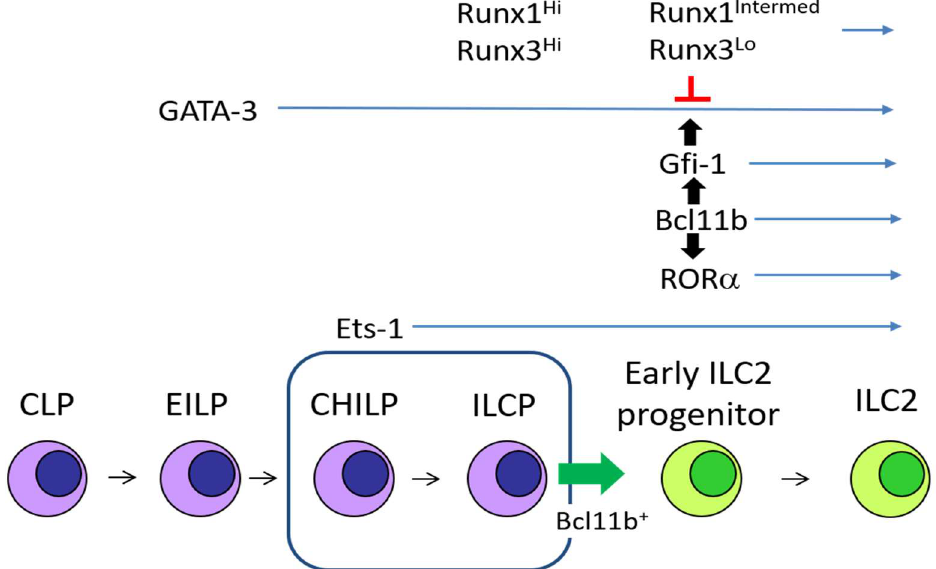
Figure 1. Group 2 innate lymphoid cells (ILC2) differentiation and transcription factors. GATA-3 is expressed in early innate lymphoid progenitor cell (EILP), and its expression is maintained in all ILC subsets. Ets-1 up-regulates Id2 in common helper innate lymphoid progenitors (CHILP). Bcl11b-expressing progenitors in the CHILP population give rise to ILC2 (green blocked arrow). Bcl11b positively regulates RORα and Gfi-1 both of which are indispensable for ILC2 differentiation (black blocked arrow from Bcl11b). Gfi-1 induces GATA-3 for ILC2 specification (black blocked arrow from Gfi-1). Runx proteins repress GATA-3 activity by antagonistic binding (red T-bar).